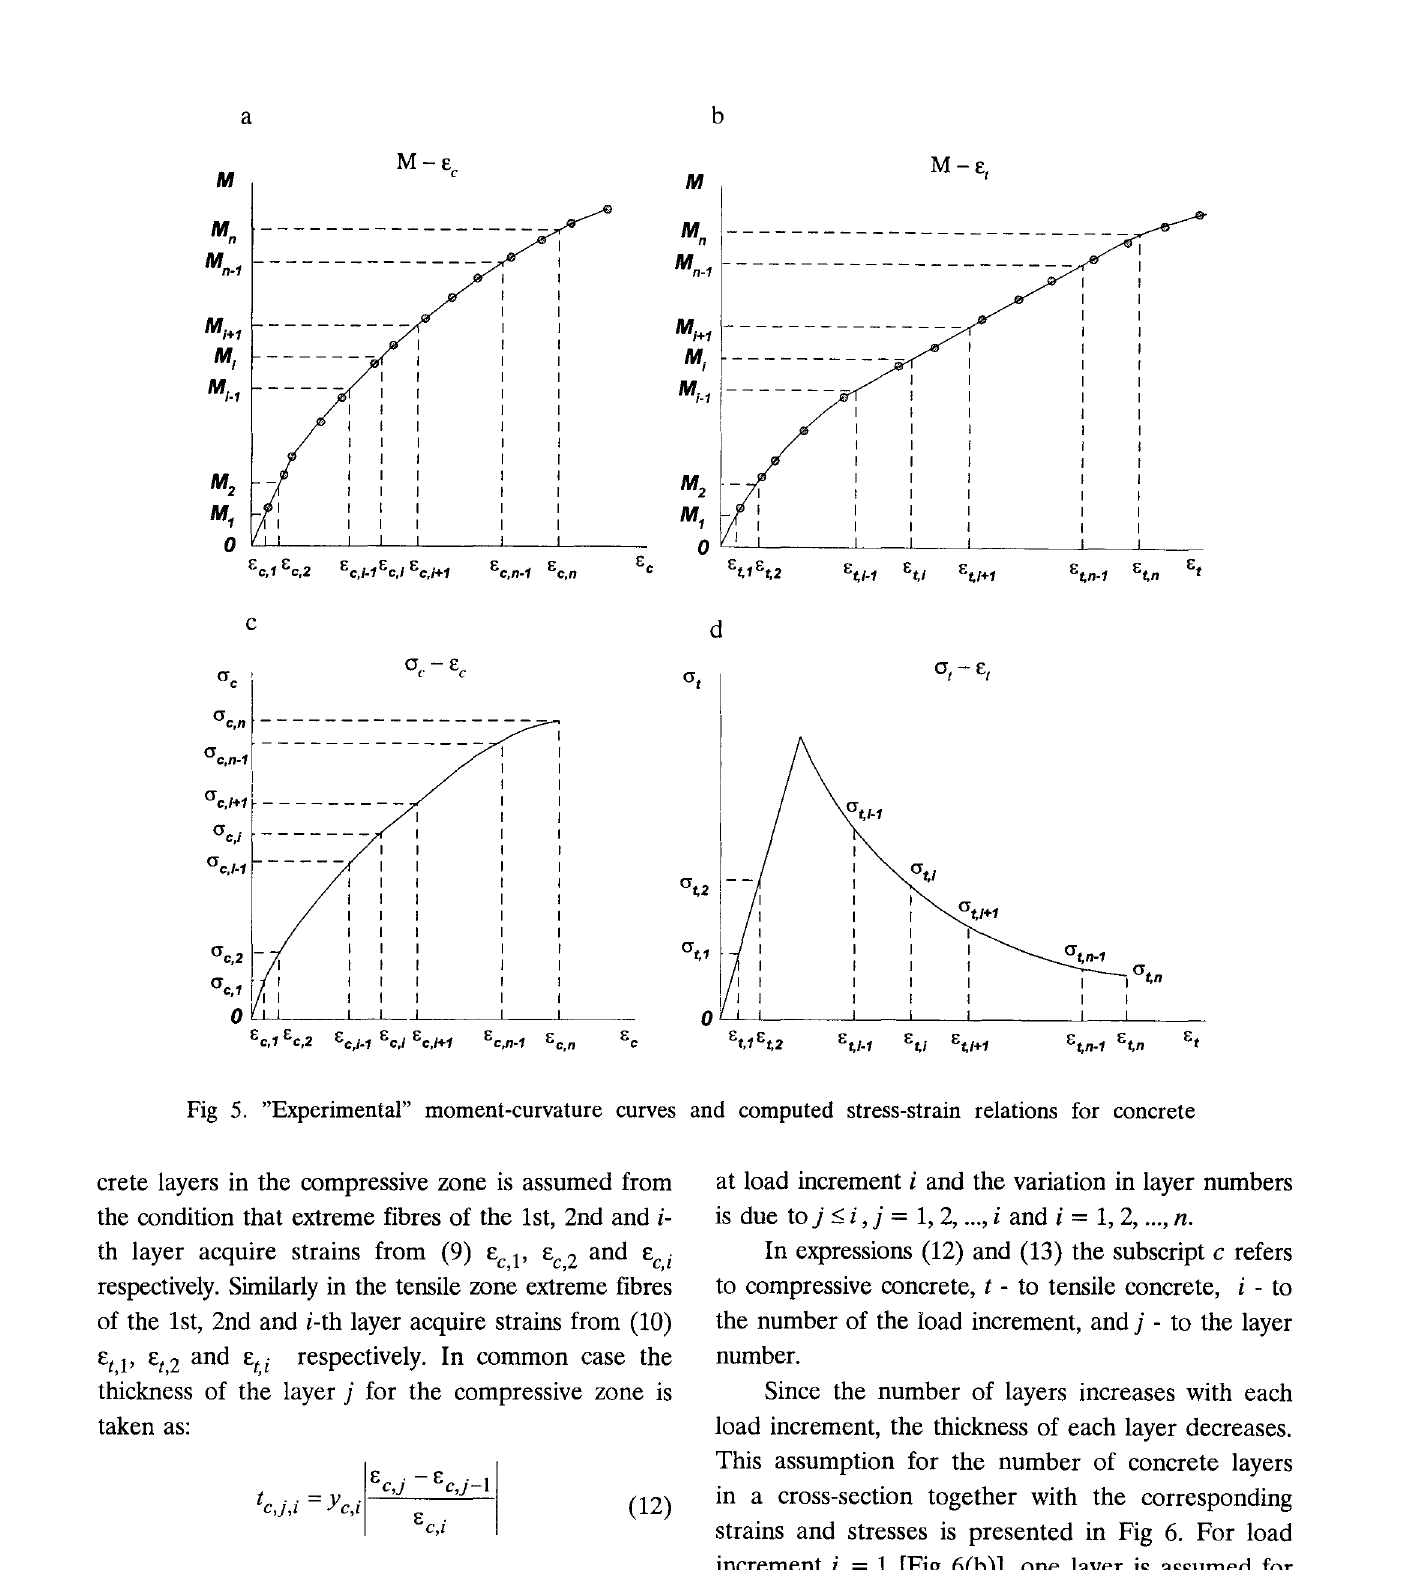
respectively. In common case